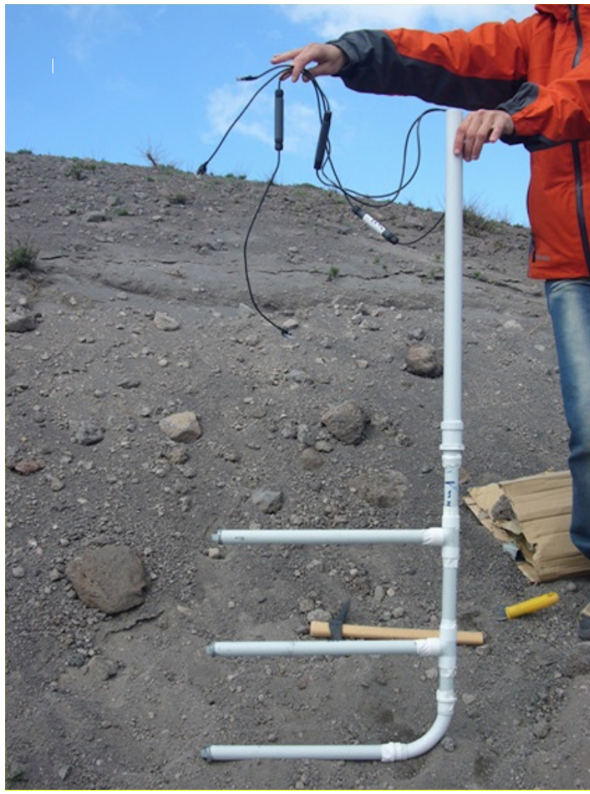
Figure 3. A typical LTF temperature monitoring station, self- powered with solar-recharged batteries and equipped with an Irid- ium satellite data transfer system, installed on the SW flank of Stromboli volcano.